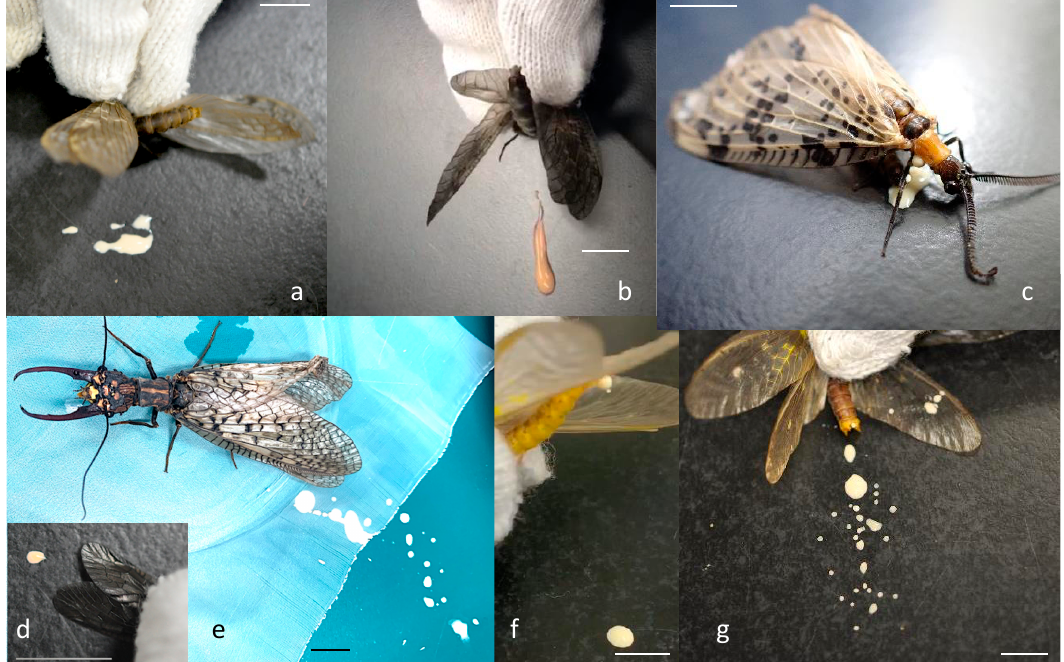
Figure 1. The fluid expelling behavior just after grasping by the thorax region of individual alderflies ( d : Sialis melania ), fishflies ( a : Parachauliodes continentalis , b : P. japonicus , and c : Neochauliodes amamioshimanus ), and dobsonflies ( e : Acanthacorydalis orientalis , f : Protohermes immaculatus , and g : P. grandis ). Scale bars: 10 mm. For movies of this behavior, click http://www.momo-p.com/showdetail- e.php?movieid=momo211129mn01b&embed=on.